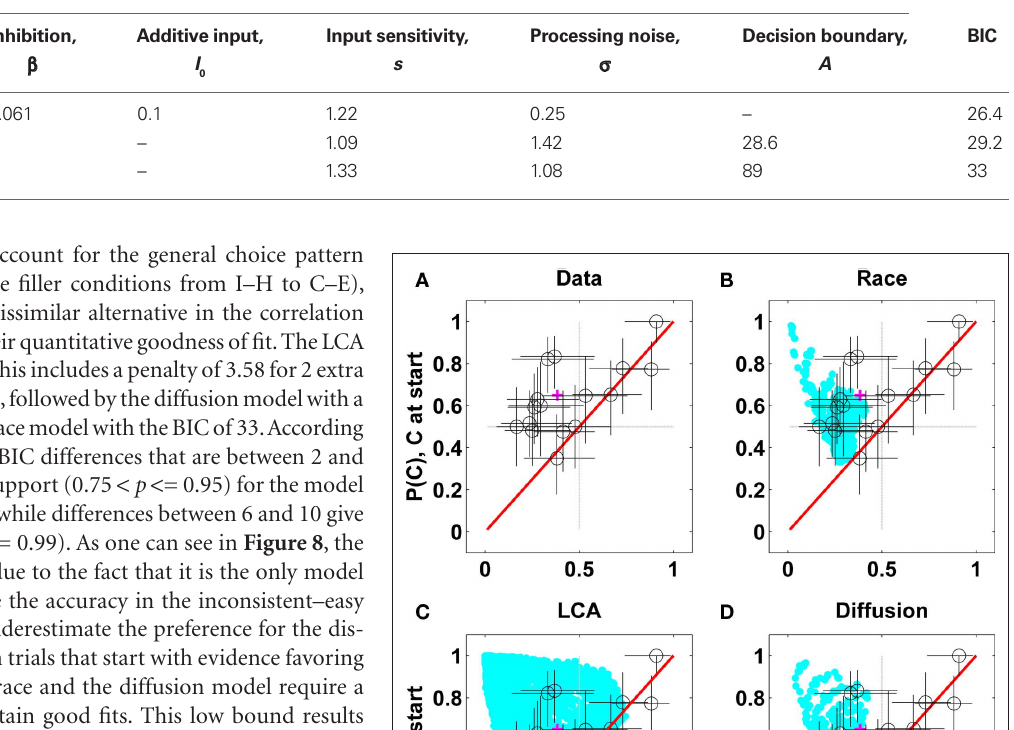
corresponds to P(C), when it received stronger evidence at the beginning of stimulus presentation. Each o-symbol corresponds to the mean choice pattern of a participant and error bars correspond to 90% confidence intervals.